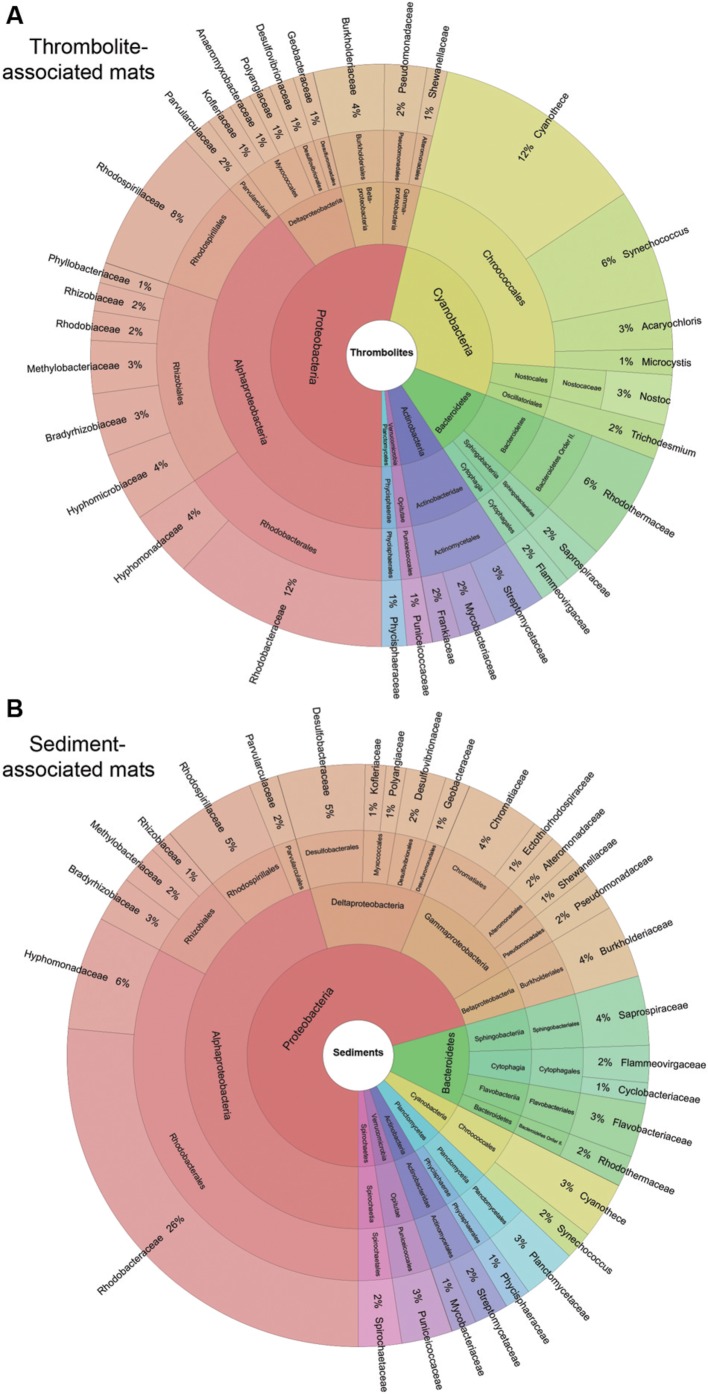
Taxonomic composition of thrombolite- and sediment-associated mat samples. Krona plot visualizing taxonomic hierarchies of the average community composition of (A) thrombolite- and (B) sediment-associated microbial mats. Only taxa with relative abundances greater than 0.5% are reported. Taxa are plotted on the same color scale in (A,B).